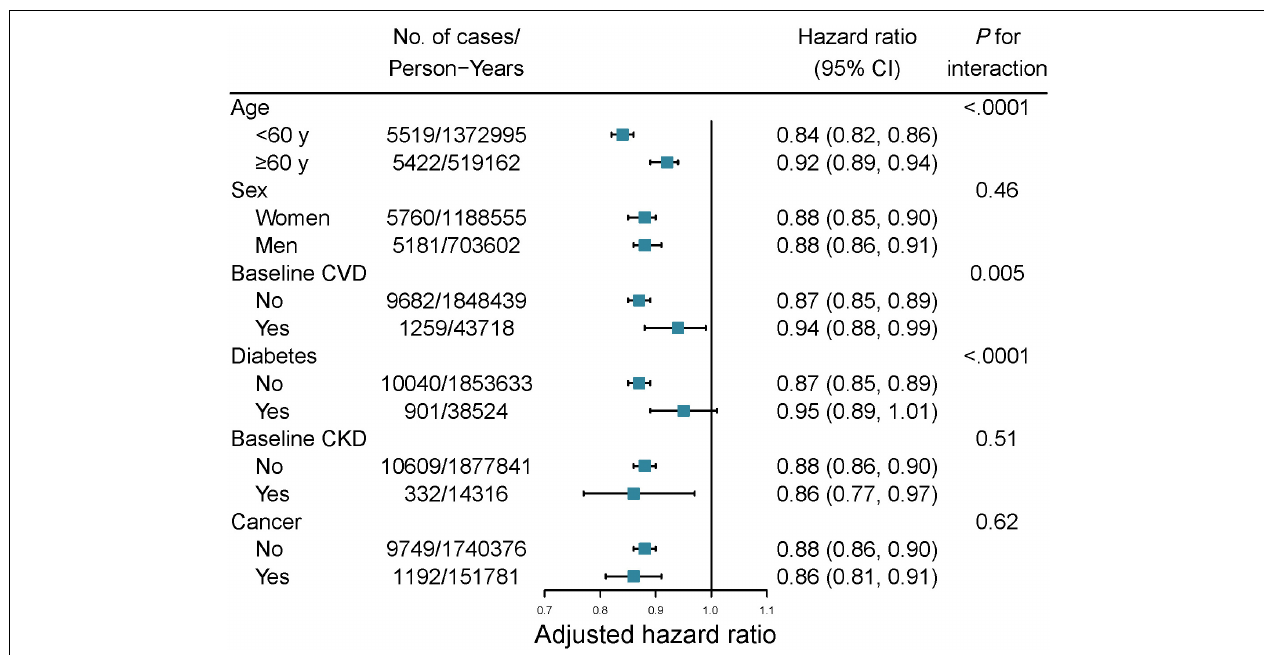
low-risk factors [BMI < 25, daily vigorous exercise > 30 min, and Dietary Approaches to Stop Hypertension (DASH) scores reported hypertension, and the PAR% was 53% (95% CI: 45%,